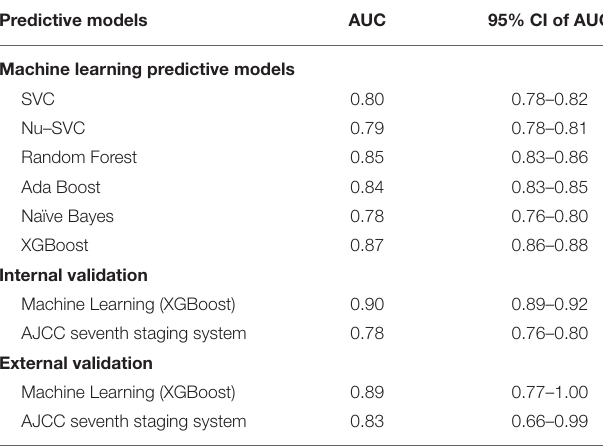
TABLE 5 | Performance of machine learning predictive models and the AJCC seventh staging system. Predictive models